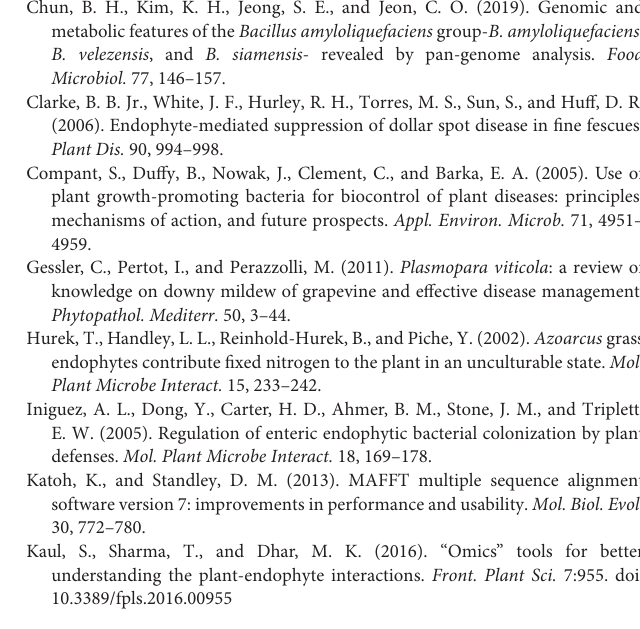
Supplementary Figure 4 | Organization of genes in B. altitudinis strains. The lchAA , lchAB , lchAC , lgrB , lgrD , and lchAD are marked with different colors. Supplementary Figure 5 | Organization of surfactin family genes in Bacillus strains. The different genes are marked with different colors. Supplementary Figure 6 | Neighbor-joining phylogenetic tree of the lchAA protein sequences derived from Bacillus and other representative species. A total of 500 bootstrap replicates were made, and bootstrap values are indicated at each node. Supplementary Figure 7 | Neighbor-joining phylogenetic tree of the lchAB protein sequences derived from Bacillus and other representative species. A total of 500 bootstrap replicates were made, and bootstrap values are indicated at each node. Supplementary Figure 8 | Neighbor-joining phylogenetic tree of the lchAC protein sequences derived from Bacillus and other representative species. A total of 500 bootstrap replicates were made, and bootstrap values are indicated at each node. Supplementary Figure 9 | Neighbor-joining phylogenetic tree of the lchAD protein sequences derived from Bacillus and other representative species. A total of 500 bootstrap replicates were made, and bootstrap values are indicated at each node. Supplementary Figure 10 | Neighbor joining phylogenetic tree of the lgrB protein sequences derived from Bacillus and other representative species. A total of 500 bootstrap replicates were made, and bootstrap values are indicated at each node. Supplementary Figure 11 | Neighbor joining phylogenetic tree of the lgrD protein sequences derived from Bacillus and other representative species. A total of 500 bootstrap replicates were made, and bootstrap values are indicated at each node. Supplementary Table 1 | Genes and gene cluster encoding for secondary metabolites in B. altitudinis GLB197. Supplementary Table 2 | Genes identified in the genomes of B. altitudinis strains GLB197 involved in plant-bacteria interaction according to the wed-based tool